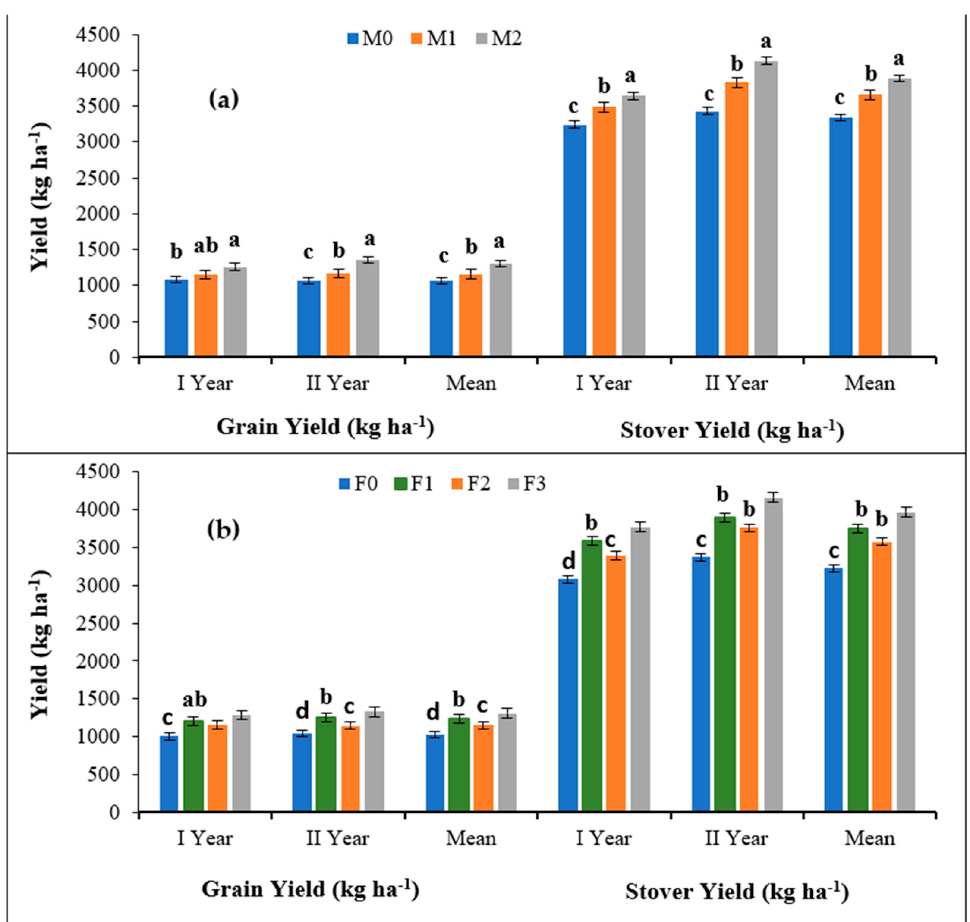
Figure 1. ( a ) Different methods of molybdenum and ( b ) Zn application on the grain and stover yield of cowpea over two years. The column representing the mean with a similar or dissimilar letter(s) was evaluated with the least significant difference (LSD) multiple range tests using a probability level of p ≤ 0.05 along with standard deviation.